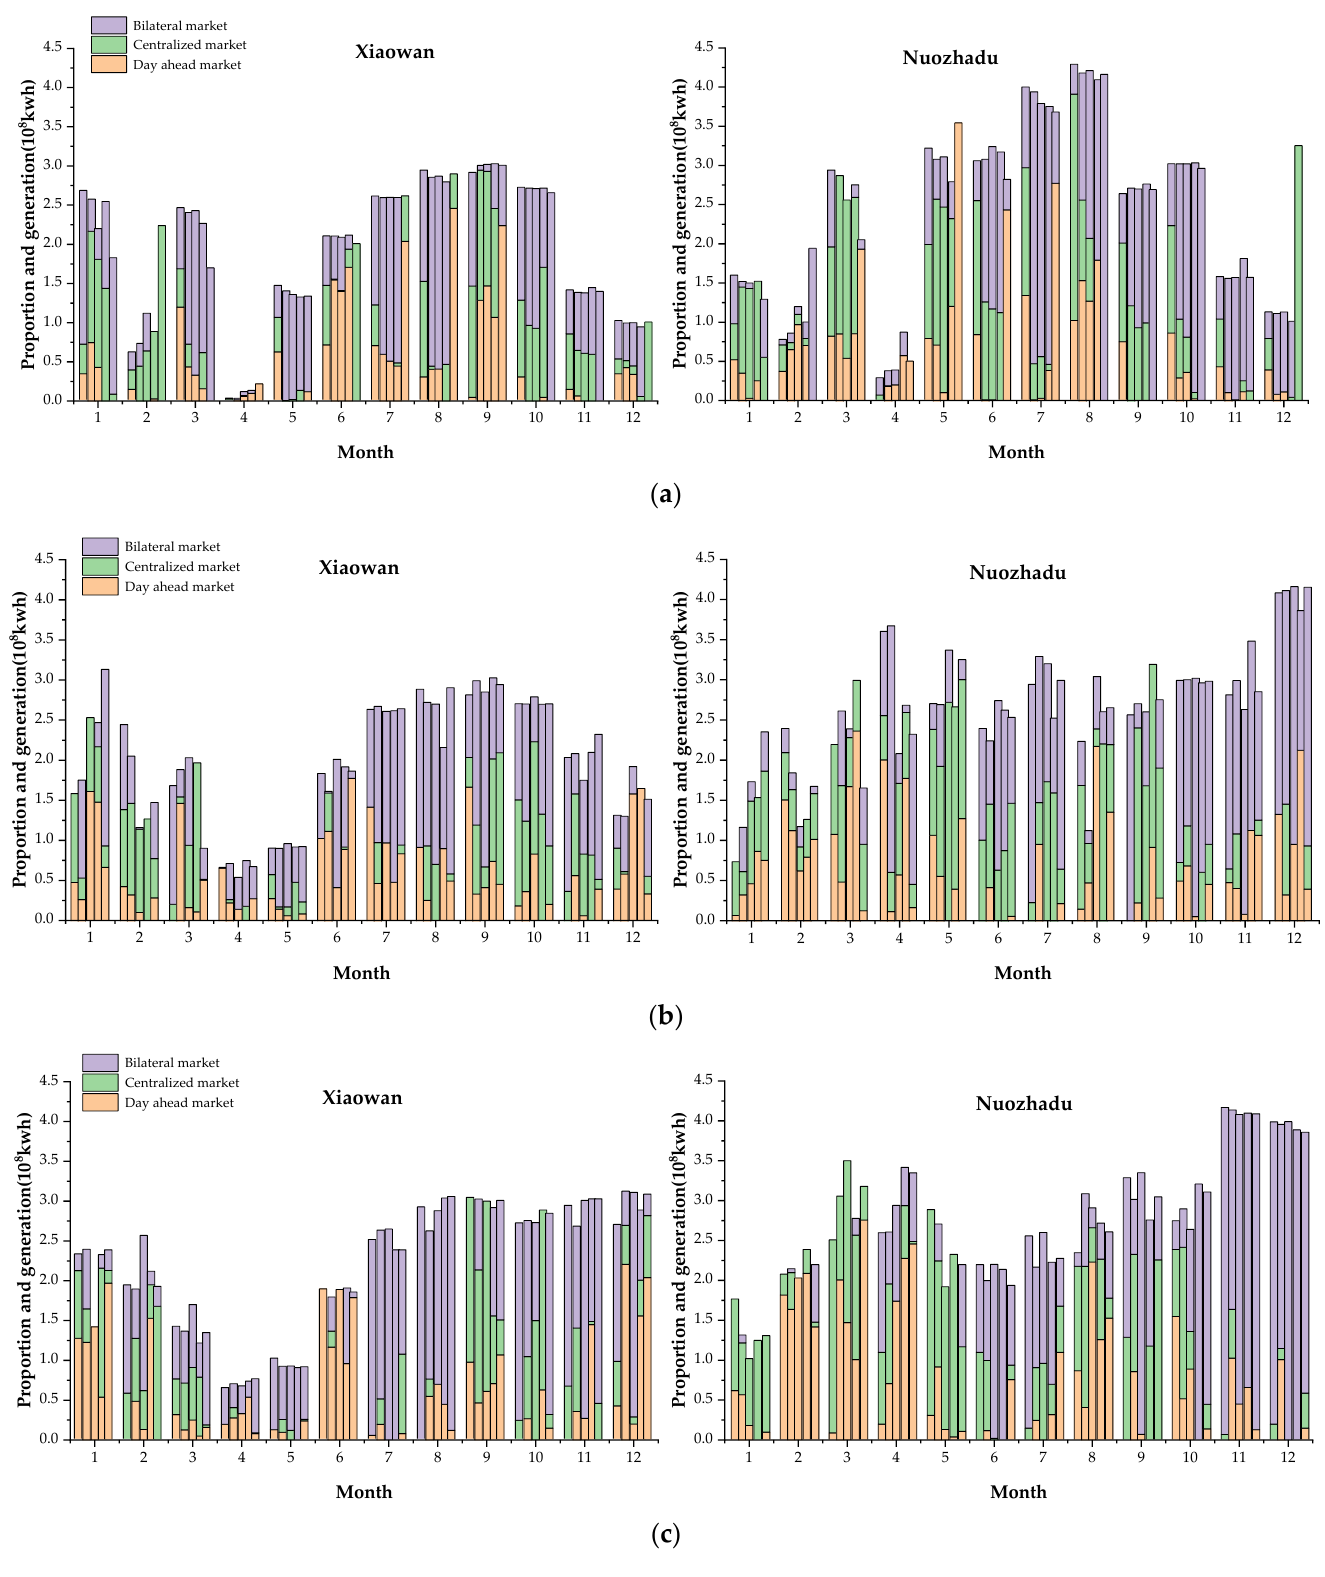
Figure 7. Market portfolio and generation of regulating reservoirs in schemes 1 to 15. ( a ) Schemes 1 – 5; ( b ) Schemes 6 – 10; ( c ) Schemes 11 – 15.